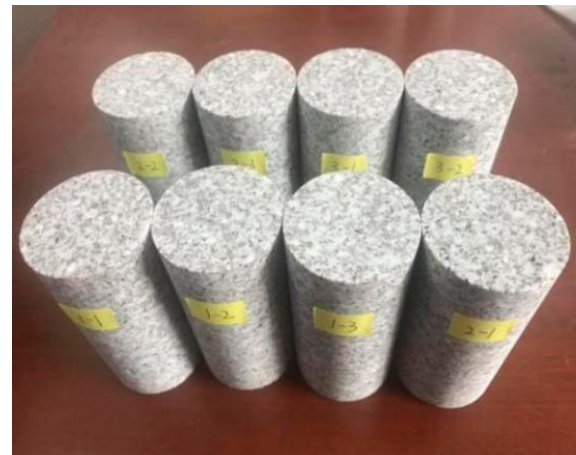
Figure 1. Demonstration photographs of some samples. In the water absorption test, the sample mass and P-wave velocity did not change when the maximum free water absorption was reached. To avoid affecting the characteristics of the sample, a water absorption test was carried out without drying. The test results are shown in Figure 2. The trend of the water absorption curve of each sample was similar. Within 42 h, the free water absorption of the granite changed significantly, and the free water absorption, W a , increased from 0% to 0.150%. Owing to the density of the granite, low porosity, and slow water absorption, the initial water absorption of the rock sample increased rapidly. With the increase in water content in the pores, the water absorption growth rate gradually slowed down. From 306 h to 546 h, the free water absorption of the rock samples was essentially unchanged. Therefore, the water absorption test was stopped after 546 h, when the granite samples had reached the maximum free water absorption. The test results of P-wave velocity are shown in Figure 3 and were between 3350 and 4850 m/s. In the initial 6 h, the P-wave velocity increased rapidly. It can be seen from the water absorption test that the water absorption rate also increased rapidly during this period. When the water content in the pores increased to a certain value, the water absorption capacity of the rock sample decreased but continued to increase slowly, along with a slow increase in P-wave velocity. After 210 h, the P-wave velocity gradually tended to stabilize; however, because the water absorption still had some fluctuation, the sample reached maximum free water absorption after 546